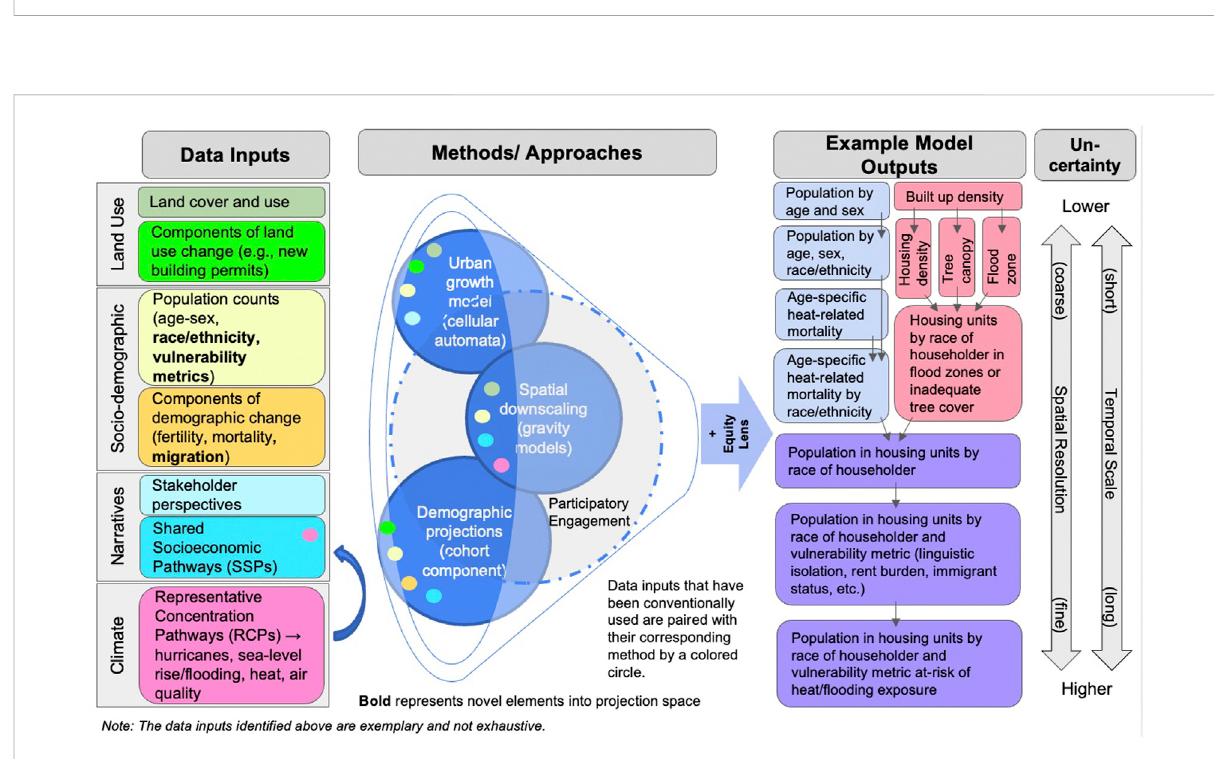
FIGURE 3 Framework for integrated modeling of local and regional population and land use projections with equity